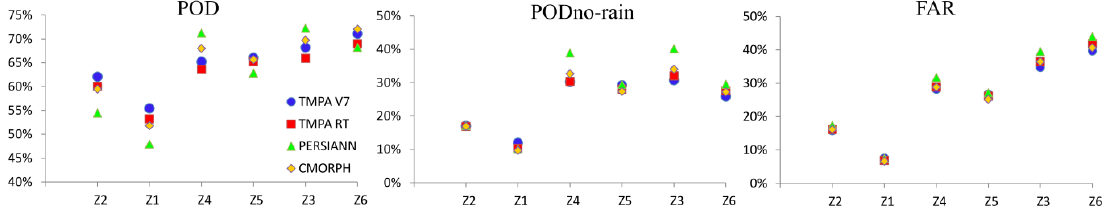
Figure 6. Probability of detection of rainy days (POD), dry days (PODno-rain) and false alarm ratio (FAR) for each zone. Zones are ranked in descending order of annual accumulation.